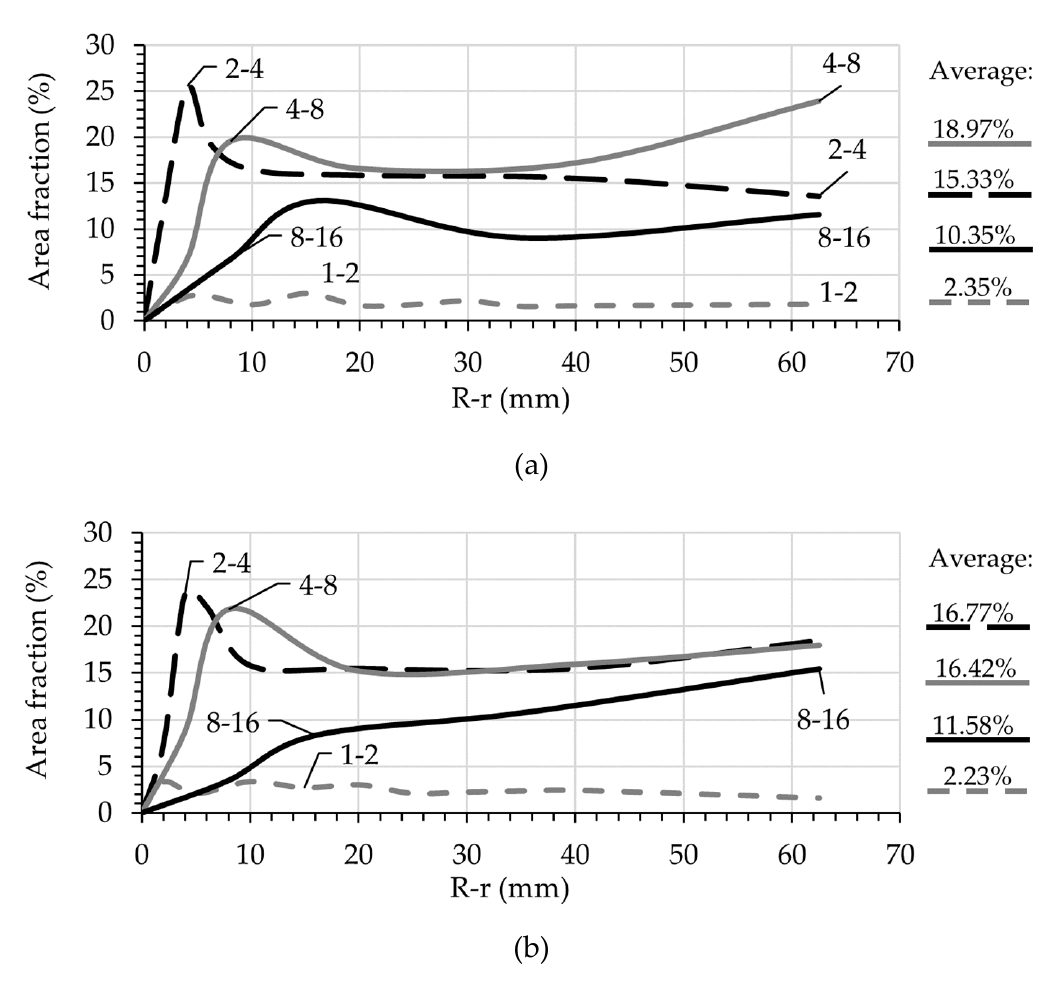
Figure 11. Surface area occupied by different groups of particles over the radial direction after pumping for ( a ) S47 and ( b ) C47. The overall average for each size is listed on the right side of the graph. Generally, if all the particles larger than 1 mm are traced, it is expected that the average area fraction for each group is equal to its volume-fraction in the mixture composition. However, due to the irregular shape of the particles, the tip of a larger particle can be erroneously classified as belonging to a smaller particle size range. The following remarks should be considered when using the present